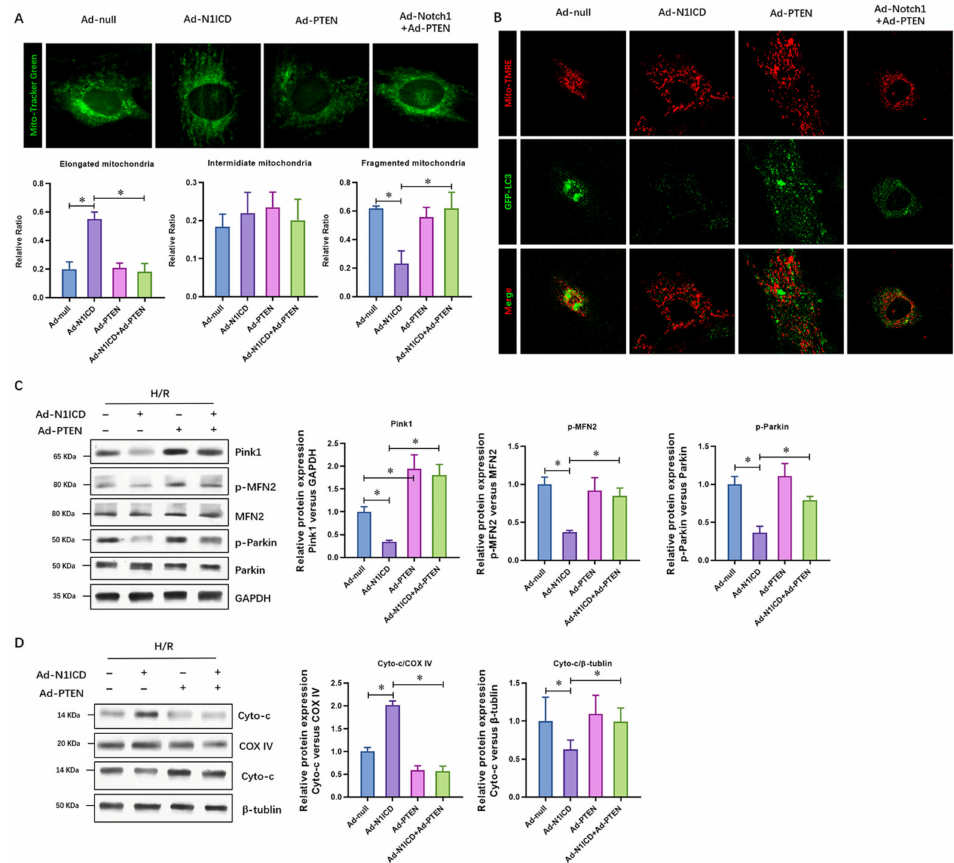
Figure 4. PTEN over-expression impaired the protective effect of N1ICD against hypoxia/reoxygenation-induced mitochondrial fragmentation and mitophagy in neonatal cardiomyocytes. ( A ) Mito-tracker Green staining and confocal microscopy were used to observe the morphology of mitochondrial fragmentation in neonatal cardiomyocytes cells; ( B ) the mitophagy in cardiomyocytes cells was analyzed via the colocalization of GFP-LC3 puncta with Mito-TMRE-stained mitochondria as an index of mitophagy in natal cardiomyocytes cells; ( C ) the regulatory molecules of mitochondrial fission and fusion, including Pink1, Parkin1, and MFN2, were analyzed; ( D ) the regulatory molecule of mitochondrial pathway apoptosis, indicated by cytochrome c release from mitochondria, was analyzed; N = 3; * p < 0.05 versus indicated